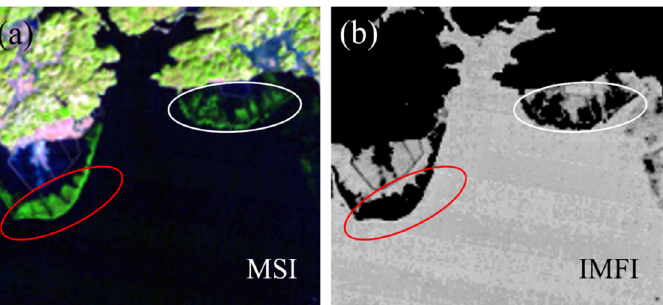
Figure 7. Comparison of multispectral imagery (MSI) and IMFI imagery. ( a ) Mangroves on MSI. ( b ) Mangroves on IMFI imagery.